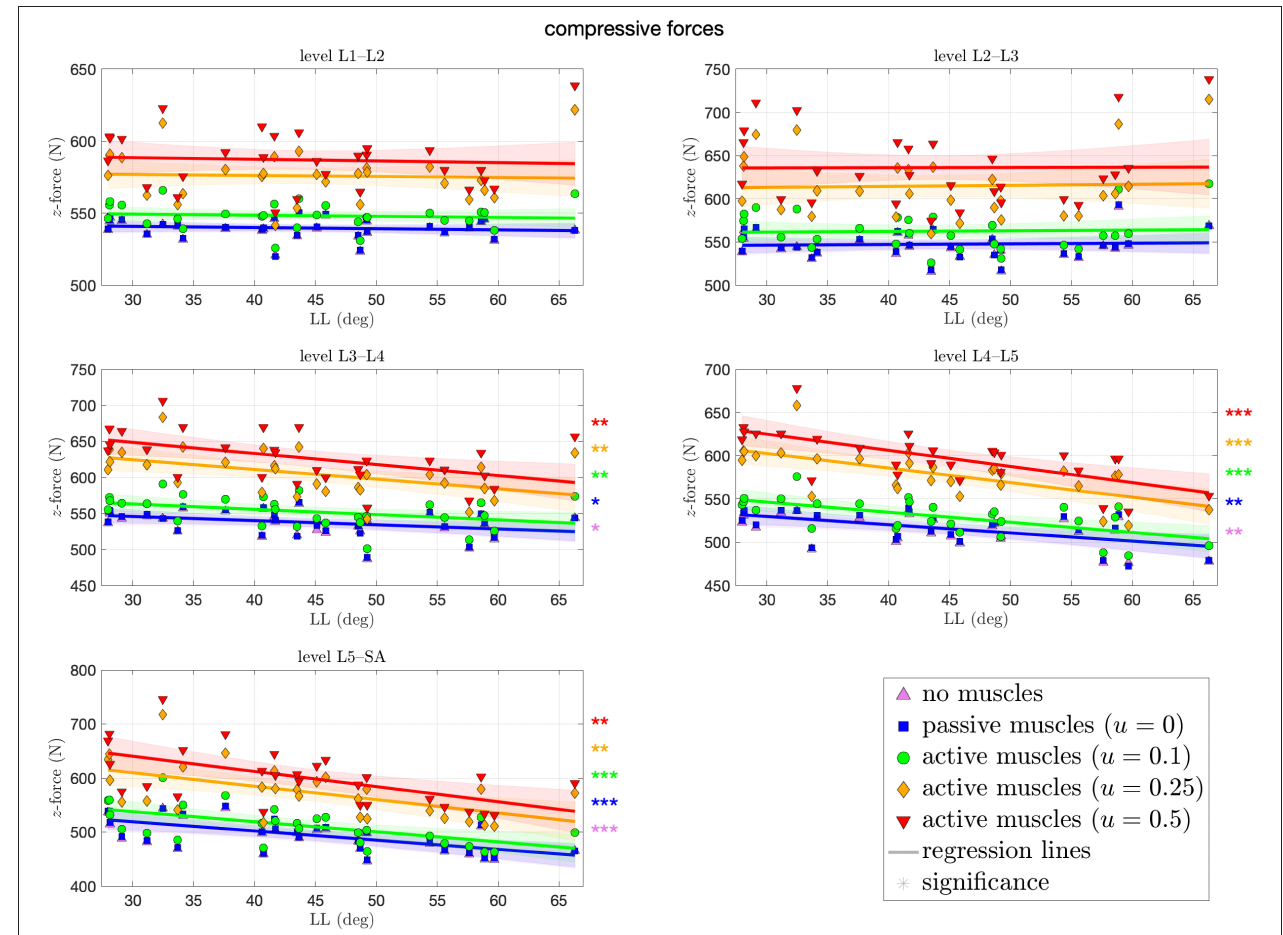
FIGURE 5 | Compressive ( z -)force between each pair of adjacent vertebrae against lumbar lordosis (LL). Colors and marker symbols of the data points and the corresponding regression lines consistently correspond to the modes: lilac up-pointing triangles for simulations without muscles involved; blue squares for passive muscles; as well as green circles, orange diamonds, and red down-pointing triangles for muscle stimulation of u the regression are shown as pale areas of the corresponding color. The significance of the statistical test is indicated by alongside asterisks (* p p < 0.05, *** 0.05 0.1, ** significant with 0.001 highly significant with p < ≤ ≤ = ≤ =